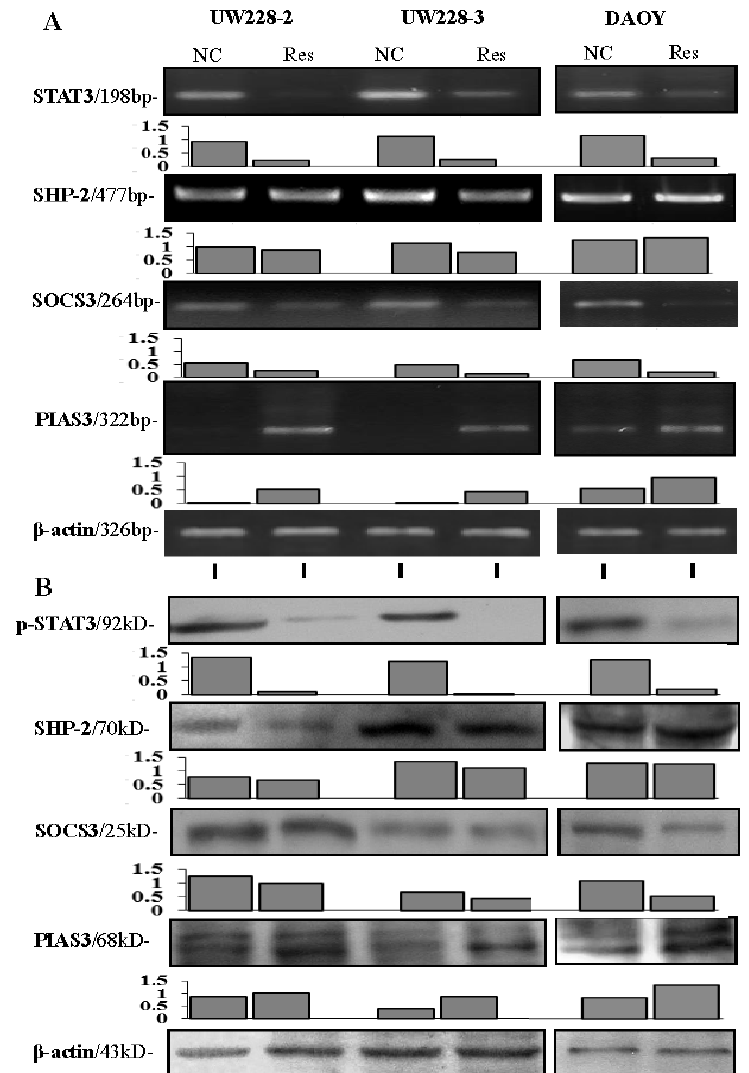
Figure 5. The results of RT-PCR ( A ) and Western blotting ( B ) and their grayscale analyses for STAT3, p-SHP2, SOCS3 and PIAS3 expression in three human medulloblastoma cell lines without and with 100 µ M resveratrol treatment for 48